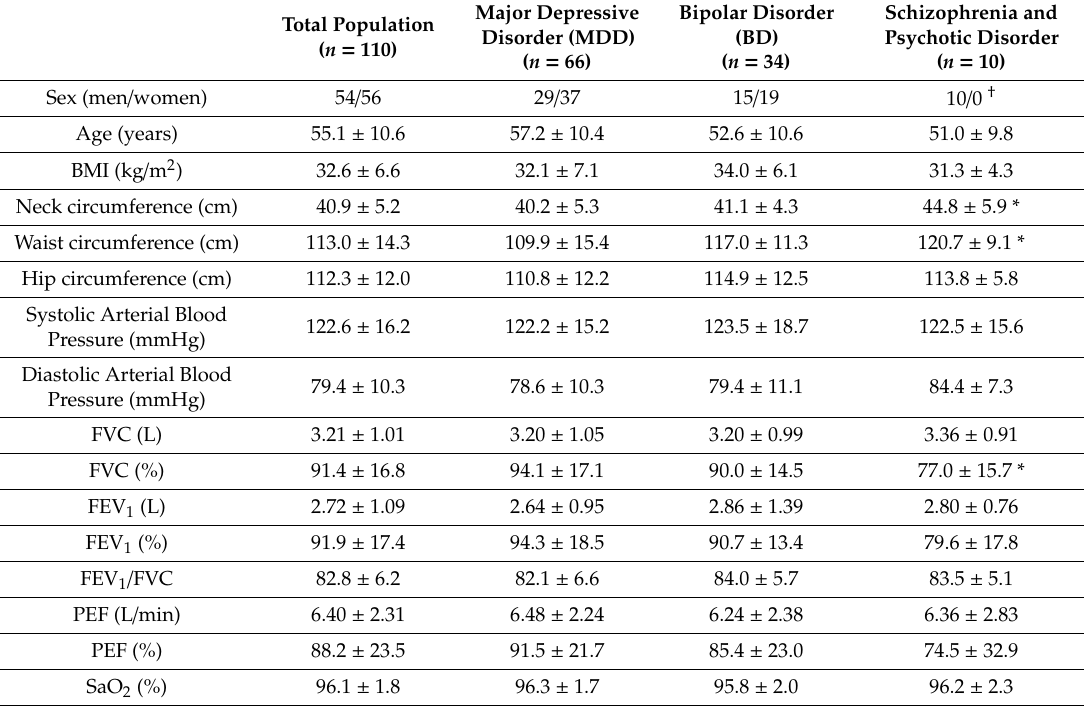
Table 1. Baseline characteristics and daytime respiratory function of the study groups (mean ±